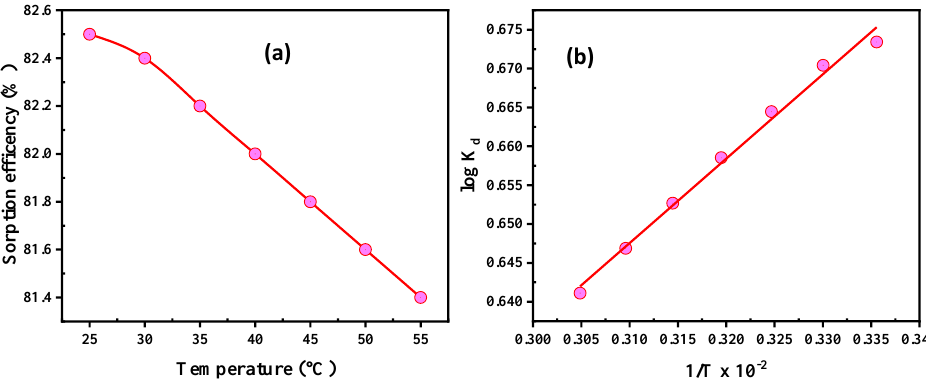
Temperatures ranging from 25 to 55 ◦ C were used to examine the effect of temperature on the adsorption of U(VI). As a result, 50 mL of water was used for the experiments, which were run for 50 min with constant concentrations of 200 mg/L U(VI), pH 3.5, and a SiO 2 /CS dose of 0.05 g (Figure 7a). By raising the temperature to 55 ◦ C, the adsorption rate drops from 82.5 to 81.4%. However, the breakdown of van der Waals bonds leads to a decrease in the number of active sites. As a result, the ideal sorption temperature is found in the ambient air.